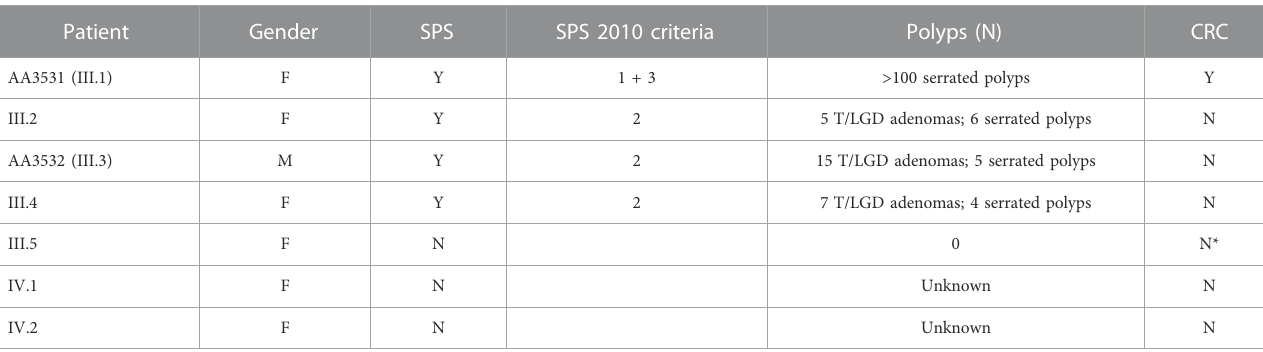
TABLE 1 Clinical characteristics of family